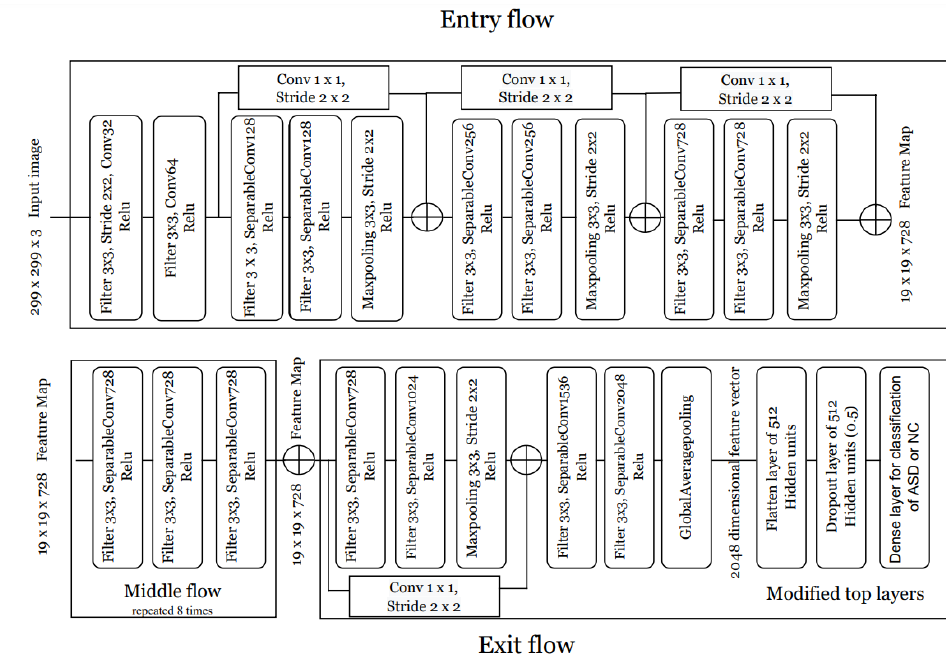
Figure 3. Modified Xception model structure (number of layers height, width, and filter size).